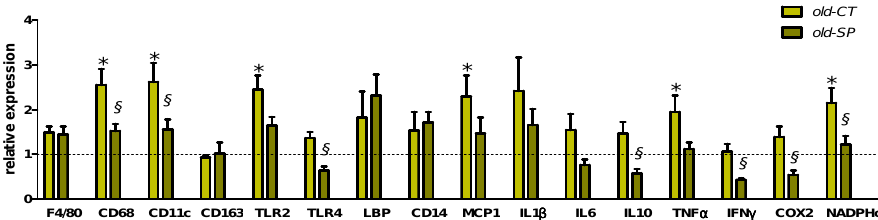
Figure 6. Expression of inflammatory and oxidative markers in the liver. Old mice were fed a standard diet supplemented with or without Spirulina for six weeks and were compared to young mice fed a standard diet. Values are expressed as relative units with the mean of young mice values set at 1; * p < 0.05 versus young mice; § p < 0.05 versus old-CT mice (ANOVA). COX2, cyclooxygenase 2; IFN γ , interferon gamma; IL, interleukin; LBP, lipopolysaccharide binding protein; MCP1, monocyte chemotactic protein-1; NADPHox, NADPH oxidase; TLR, toll like receptor; TNF α , tumor necrosis factor